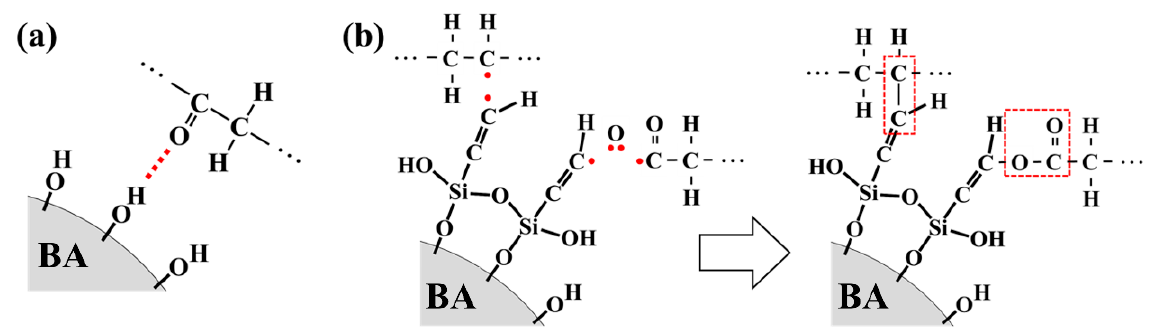
Figure 4. Bond formation between BA and HDPE ( a ); vBA and HDPE ( b ).